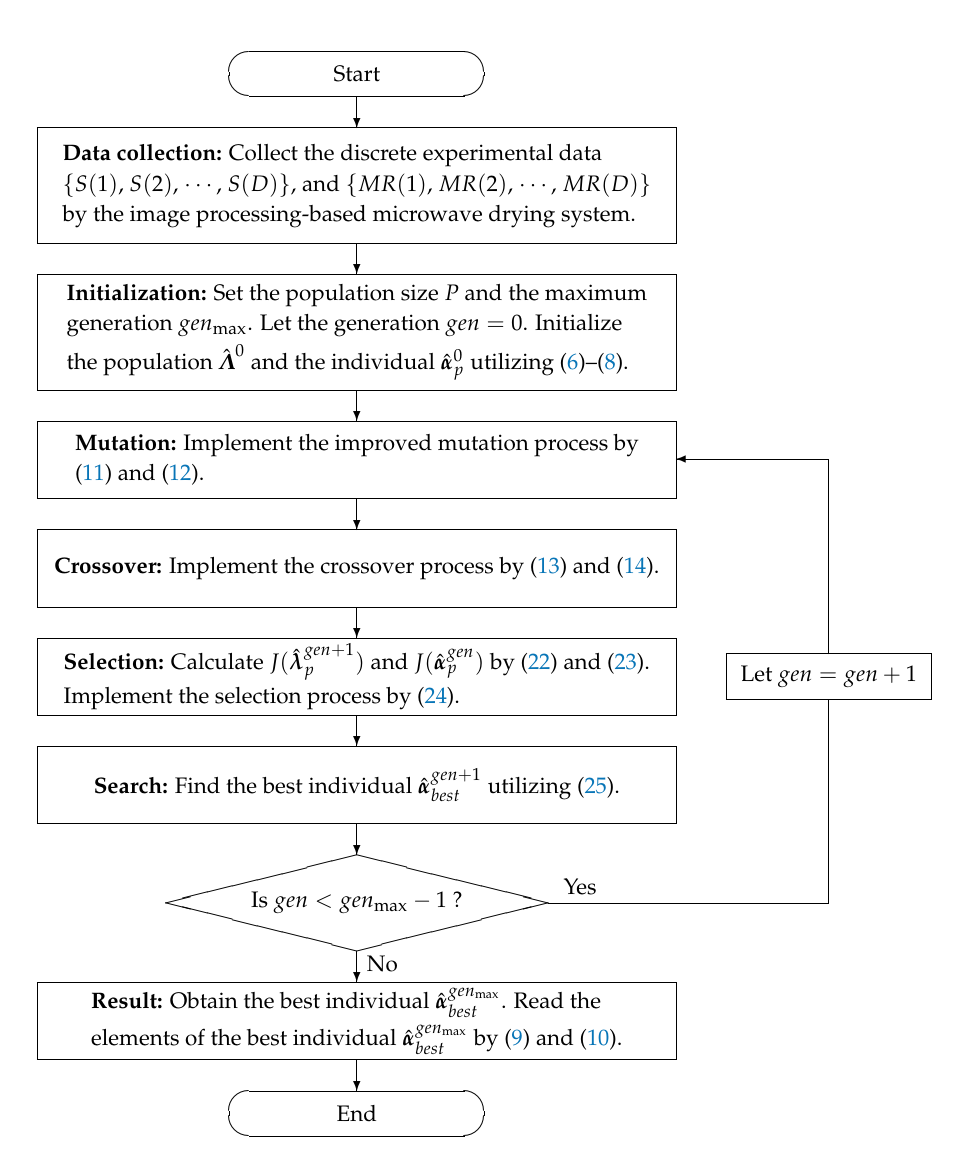
Figure 3. The flowchart of the MLFF-PE